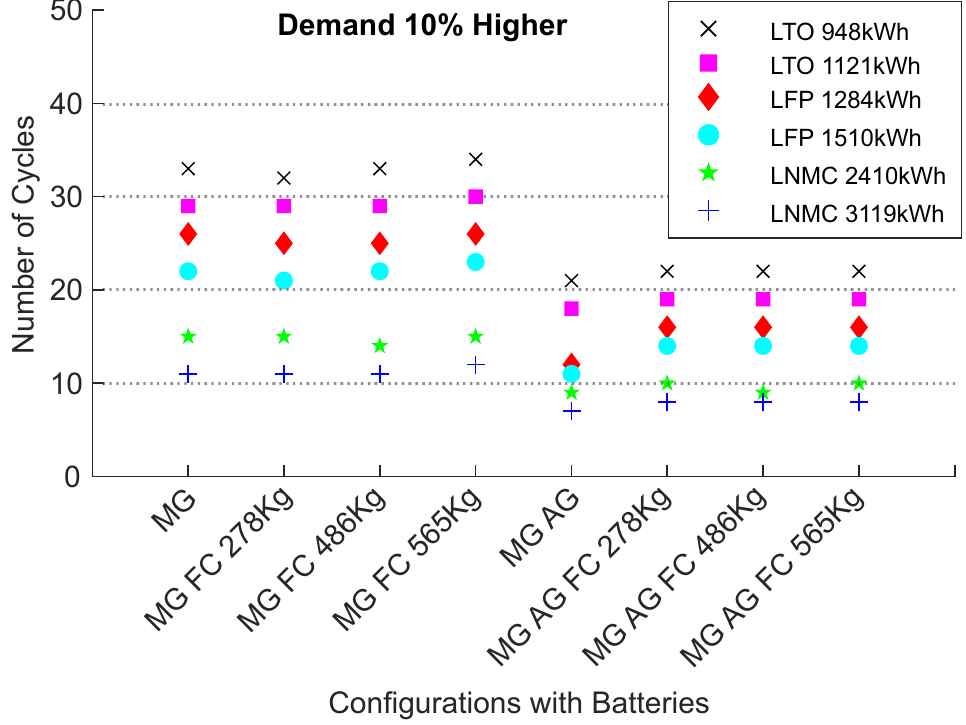
Figure 13. Number of cycles that each battery required in each configuration for a 10% higher